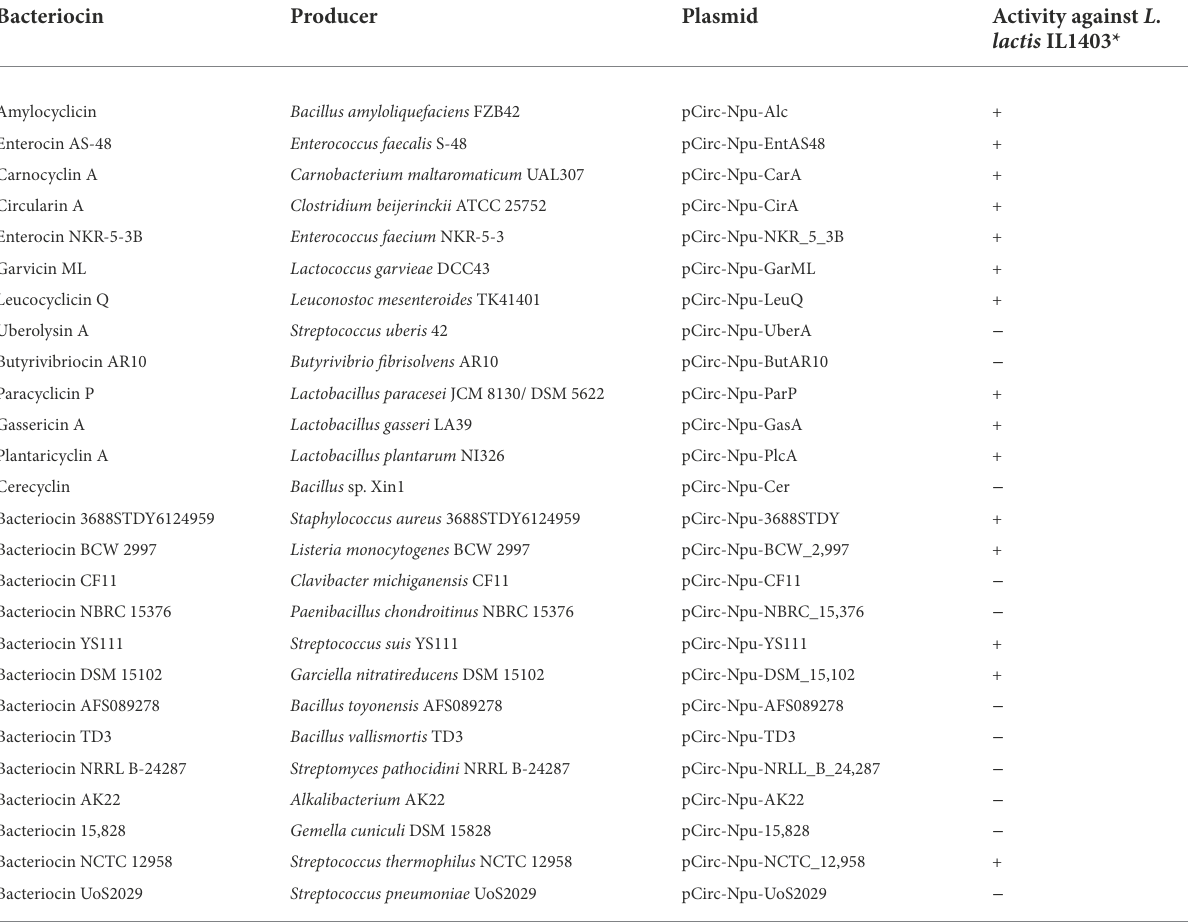
TABLE 4 Antimicrobial activity of the bacteriocins produced by the in vitro CFPS and split-intein mediated ligation (SIML) of circular bacteriocins against L. lactis IL1403. Fully characterized bacteriocins, in bold.